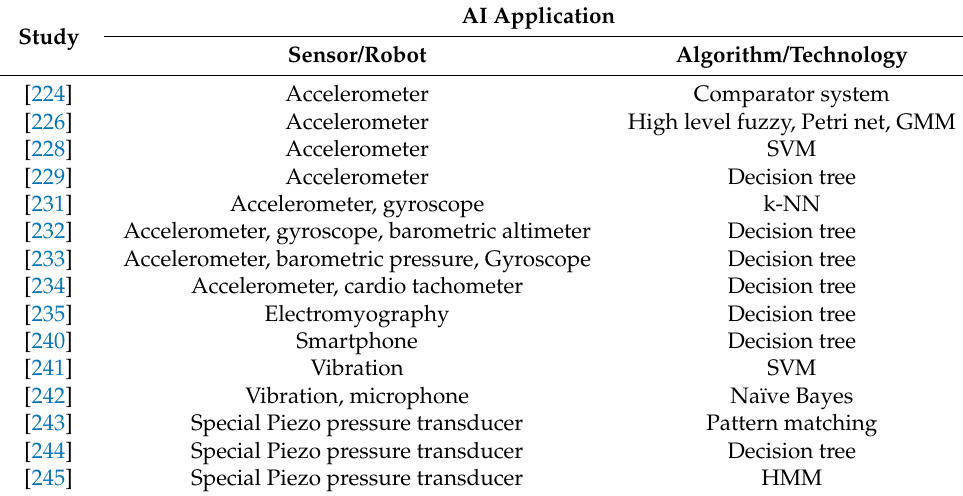
Table A5. Reports of AI Applications in Wearable Devices in